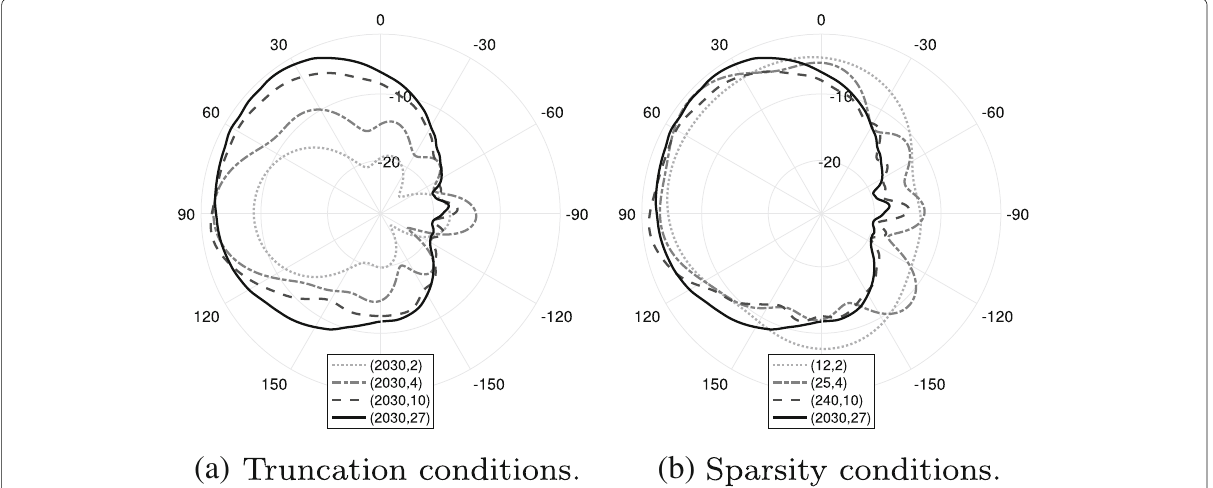
Fig. 6 Loudness over the horizontal plane of KEMAR left ear HRTF, for different truncation and sparsity conditions, convolved with low-pass filtered white noise up to 15kHz. Each line represents a different ( Q , (cid:11) N ) condition. a Truncation conditions. b Sparsity